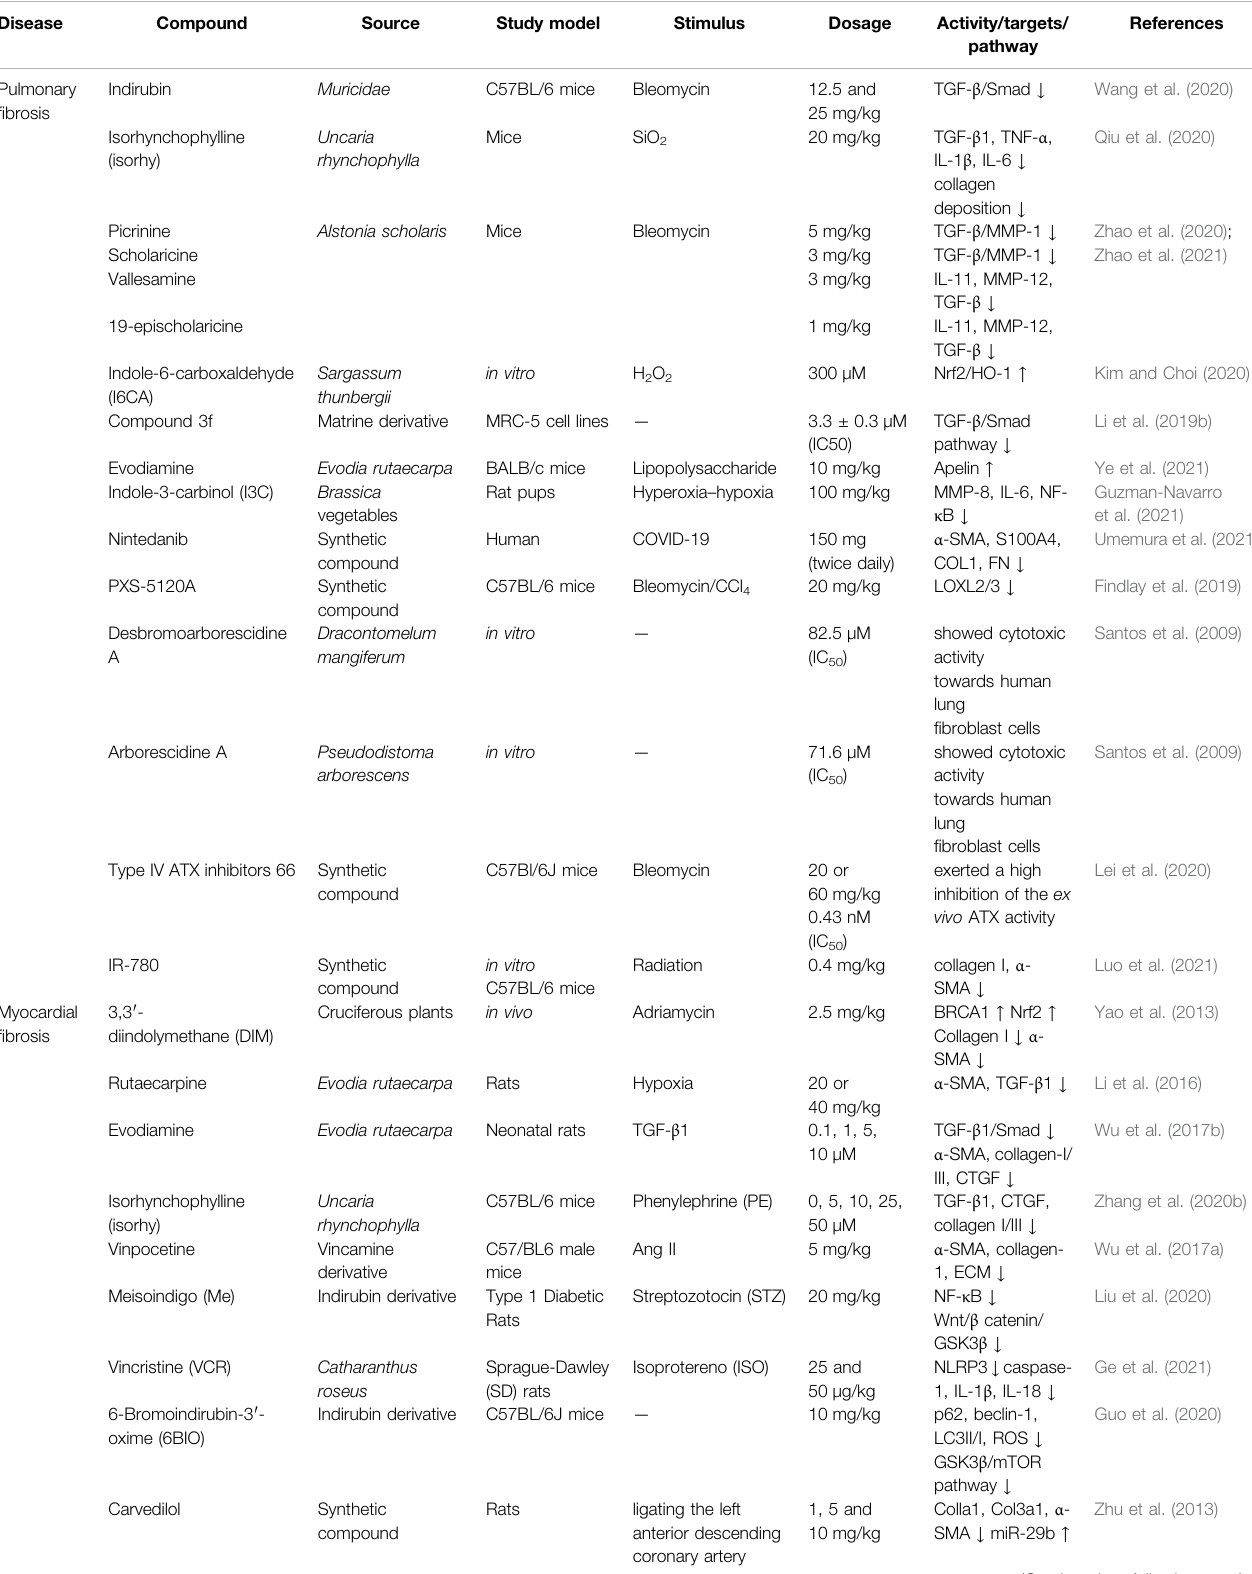
TABLE 1 | Therapeutic activities of indole alkaloids and indole derivatives on organ fi brosis.